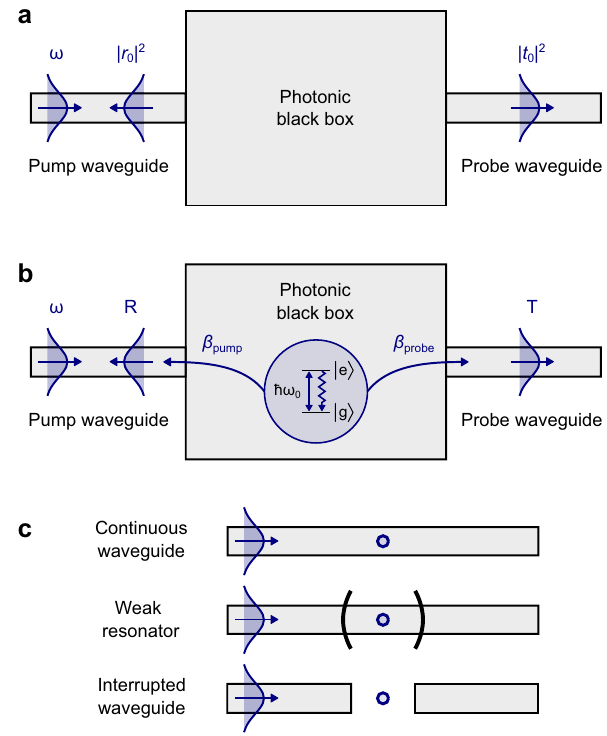
Fig. 1 Schematic representation of the optical system to be characterised. a Response of the system without the presence of a quantum emitter. Input light at frequency ω is transmitted (re fl ected) by the photonic structure with coef fi cient ∣ t 0 ∣ 2 ( ∣ r 0 ∣ 2 ). b With the presence of a single emitter with ground state g j i and excited state e j i separated by energy ℏ ω 0 , the light interferes with the resonance fl uorescence of the driven quantum system coupled to the pump and probe waveguides with ef fi ciency β pump and β probe , producing Fano transmission ( T ) and re fl ection ( R ) spectra. c Example Markovian structures covered by our general characterisation model, including a continuous waveguide, a resonator in the weak coupling regime and an interrupted